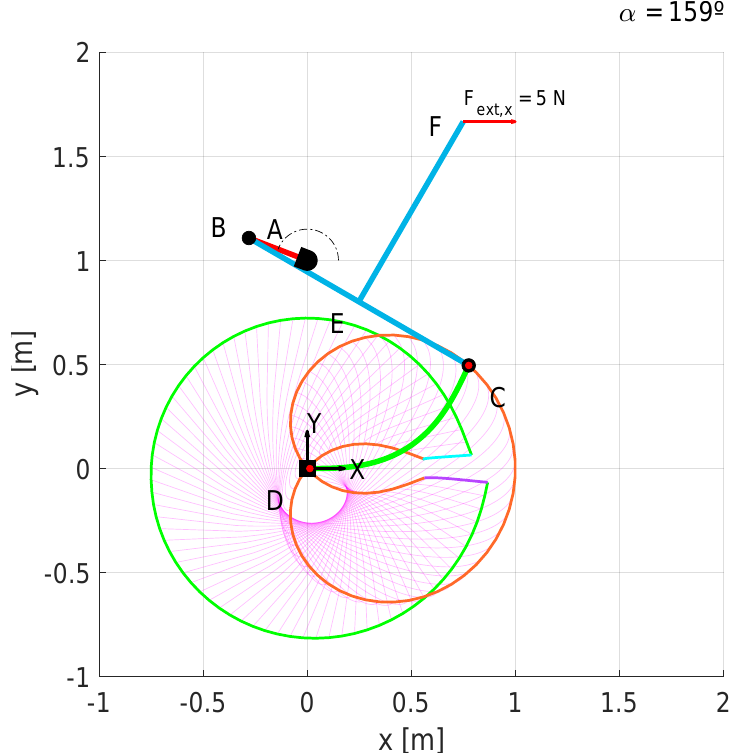
Figure 12. Cycle with buckling mode changes. Mode 1 to Mode 2 change.